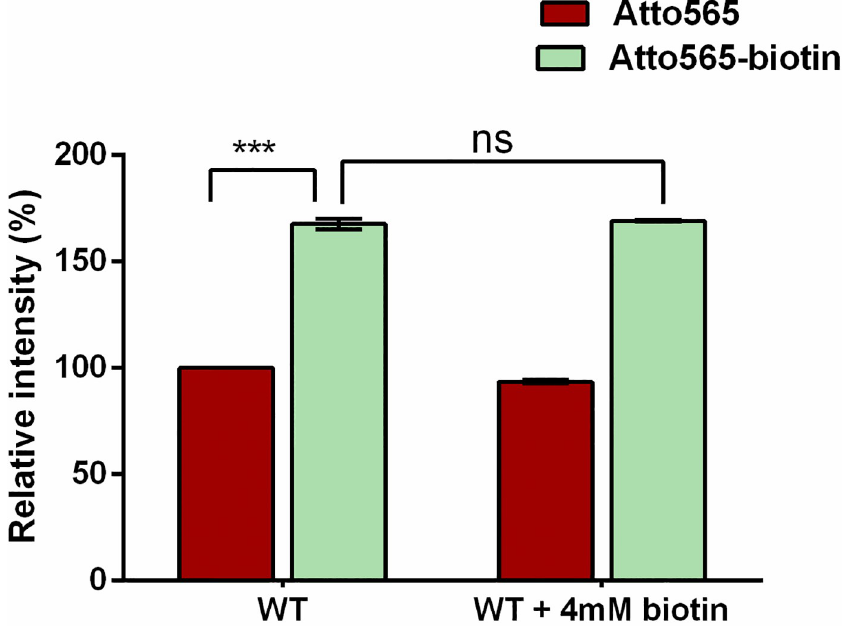
Fig 1. Accumulation of Atto565 (red) and Atto565-biotin (green) in E . coli , in the presence or absence of free biotin. Figure shows representative data from three independent experiments. Data were presented as mean ± S.D. (Two-way analysis of variance; ��� p <